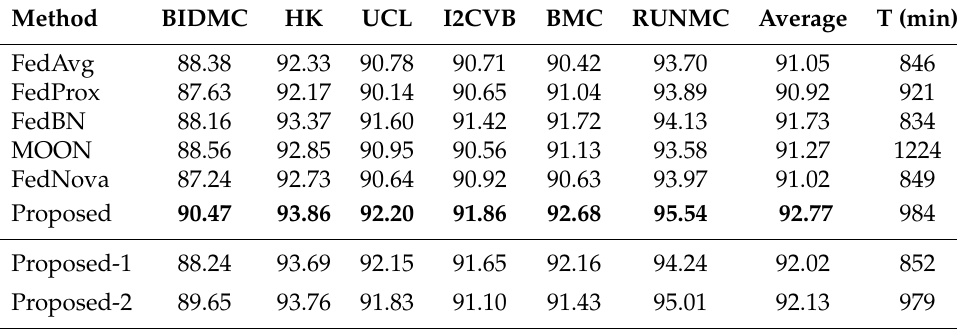
Table 2. Multi-national prostate MRI segmentation. Dice score (%) is reported. T is the total time required for model training in